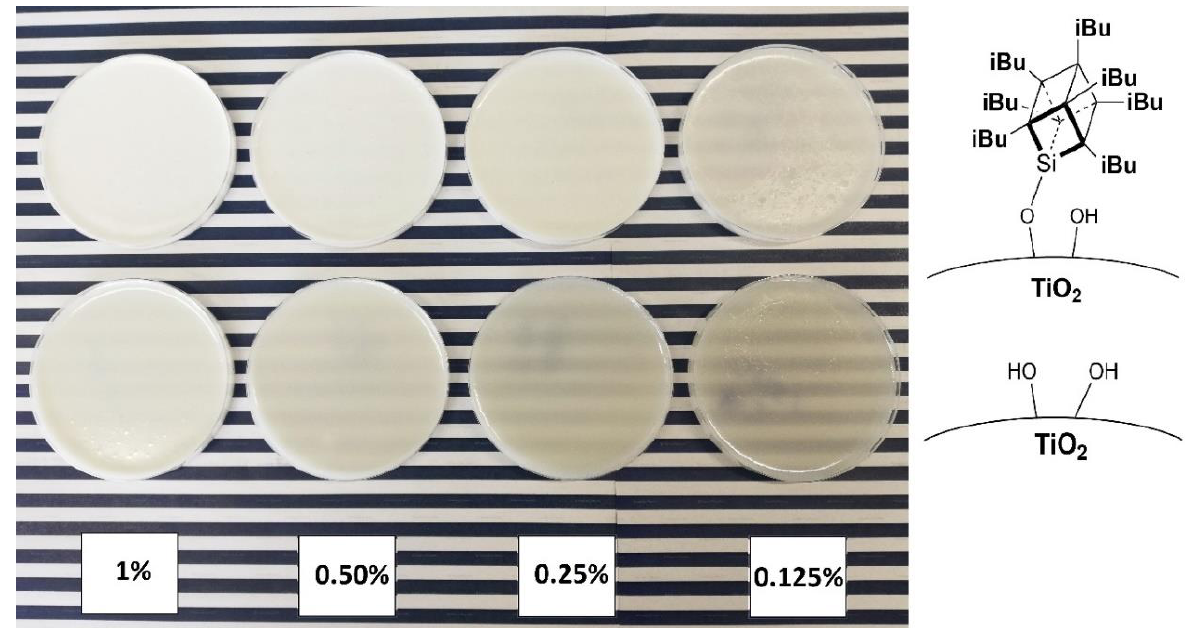
Figure 12. Serial dilution samples of mixing pump-prepared 1.5% i Bu 7 SSQ-OEt TiO 2 /EP (top) and neat TiO 2 /EP